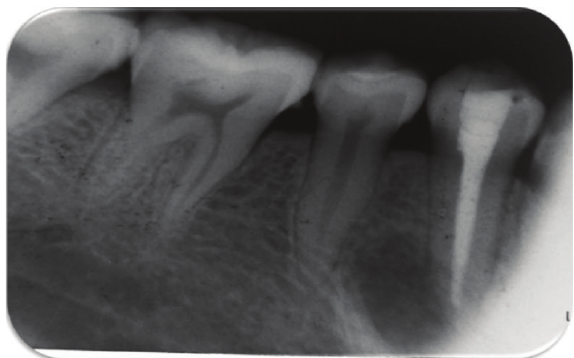
Figure 8: Six-month